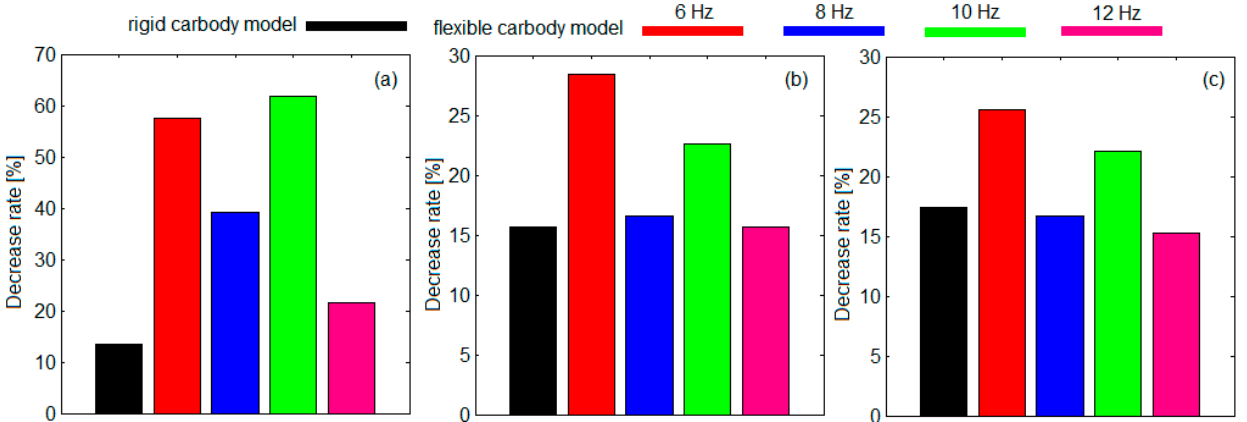
Figure 10. The decrease rate of the root mean square of acceleration with the damping ratio of primary suspension: ( a ) at the carbody centre; ( b ) against the front bogie; ( c ) against the rear bogie.